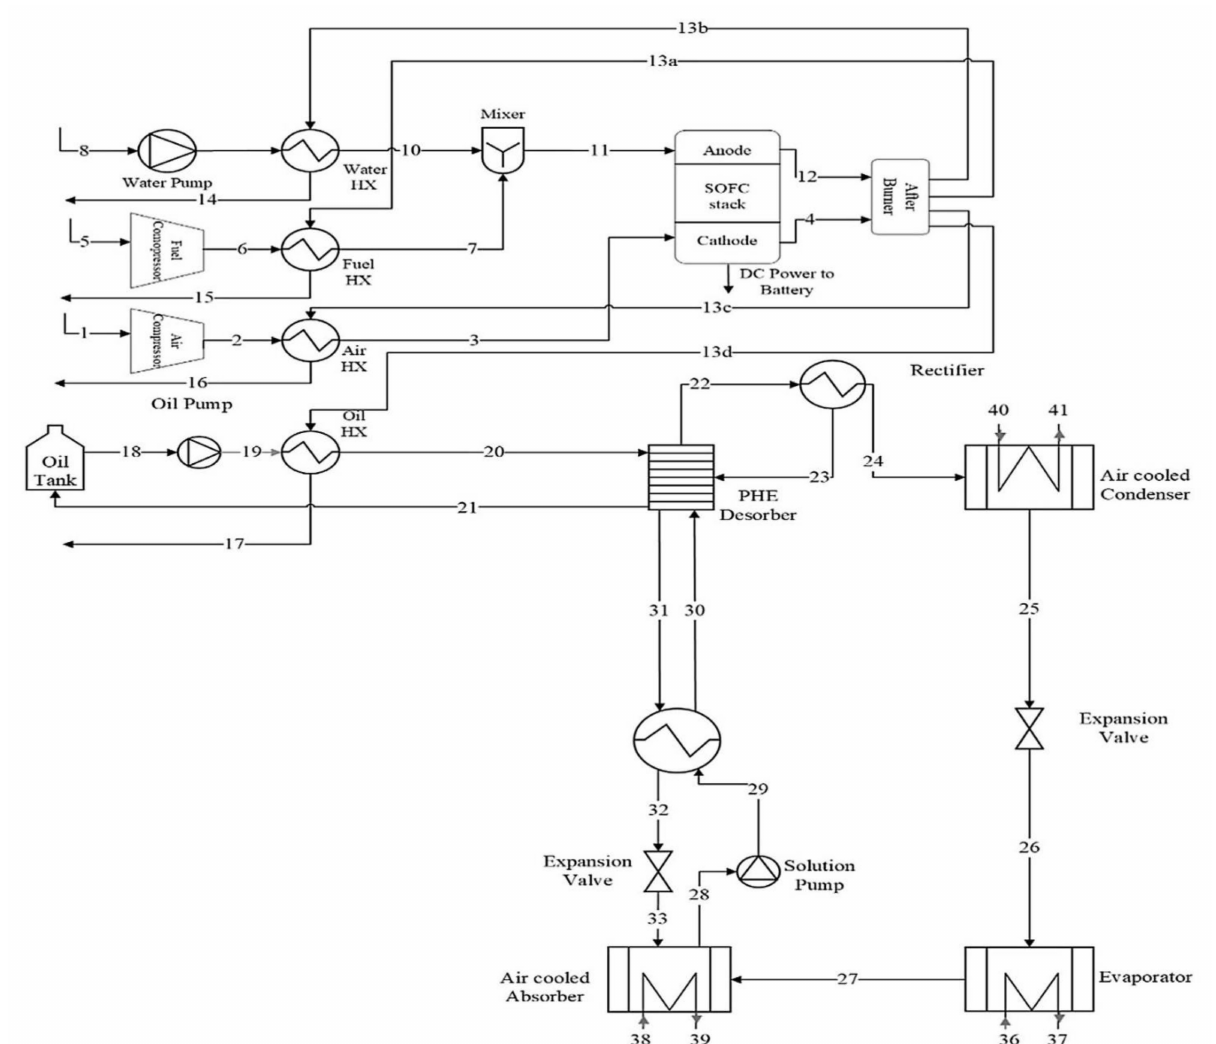
Figure 17. Parallel configuration of heat exchangers. Reprinted from ref. [57] (Pandya et al., 2020), Copyright (2020), with permission from